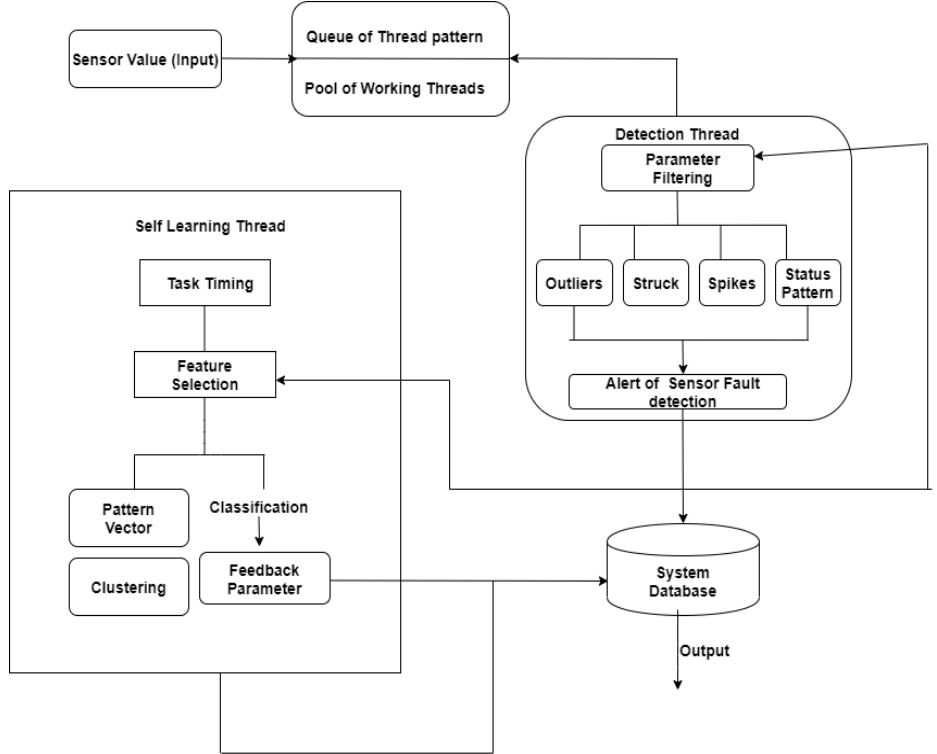
Figure 9. Self-learning fault detection structure.